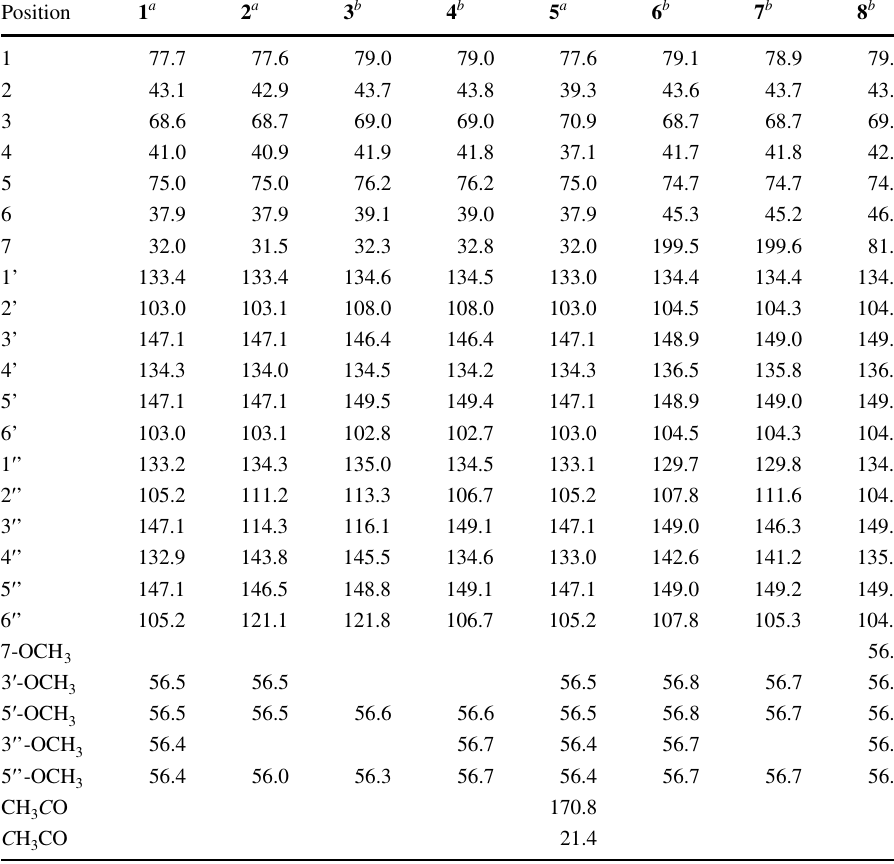
Table 2 13 C NMR (125 MHz) data for compounds 1 – 8